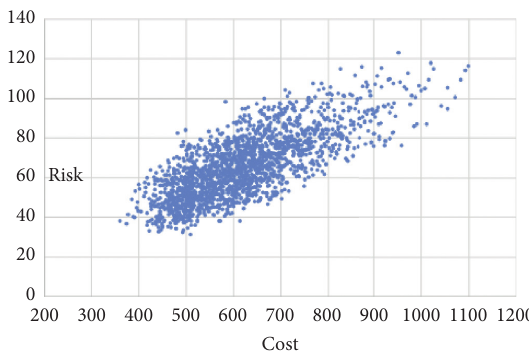
Figure 11: Pareto nondominated solutions between nodes starting at 7:00.